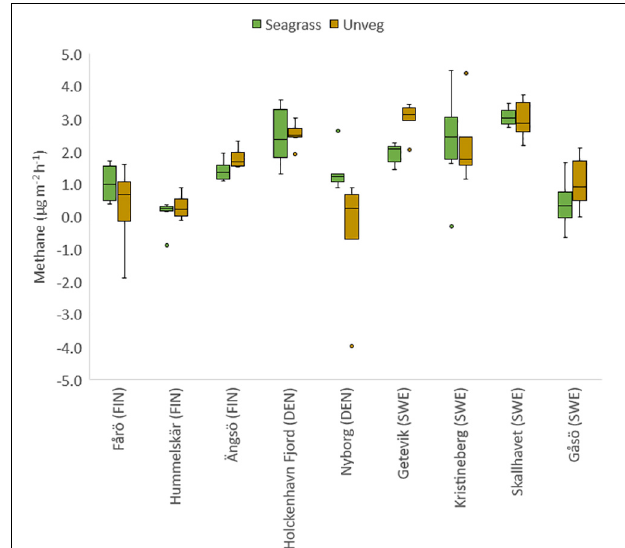
FIGURE 3 | Box-and-whisker-plot showing the variation of methane emission from the sediment to the gas-filled pocket in the incubation chambers of seagrass meadows and adjacent unvegetated areas in Finland (FIN), Denmark (DEN), and Sweden (SWE). The solid lines within the boxes indicate median values, the boxes represent the 25th to the 75th percentiles and the vertical whisker bars show the 5th and 95th percentiles of the data.